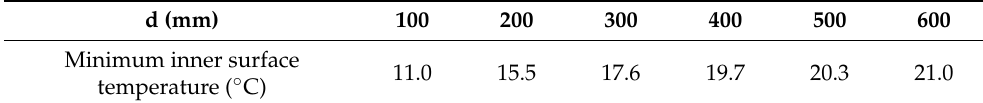
Table 6. Minimum Temperatures of Inner Surfaces of Rammed Earth Walls of Different Thicknesses.